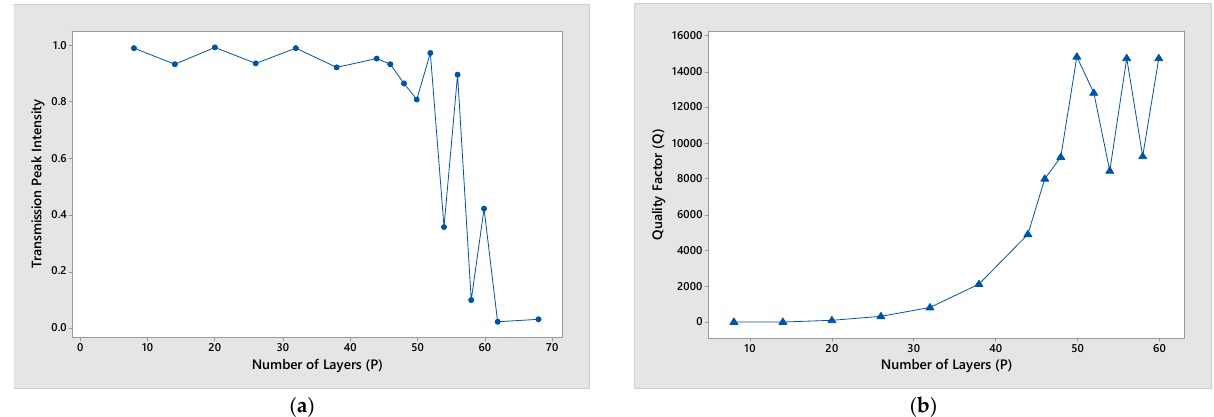
5 of 12 Table 1. Variation of the Peak Intensity, Peak Wavelength, Peak FWHM and the Q- factor for Dif- ferent Values of P . Number of Layers (P)